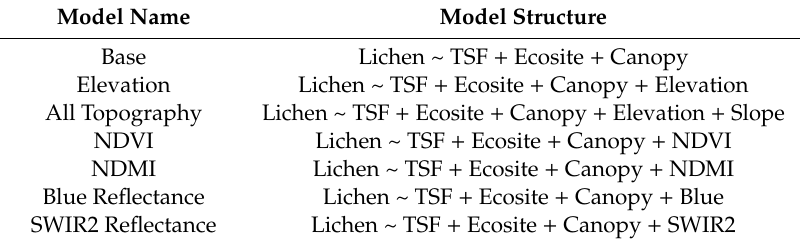
Table 3. Name and structure of candidate models used to predict lichen presence (0,1) and lichen abundance (biomass, kg / ha) as a function of forest structure, topographic and remote sensing attributes. Covariates within the same model have a Pearson’s correlation coe ffi cient < | 0.6 | . TSF = time-since-fire, Canopy = canopy closure, NDVI = normalized di ff erence vegetation index, NDMI =